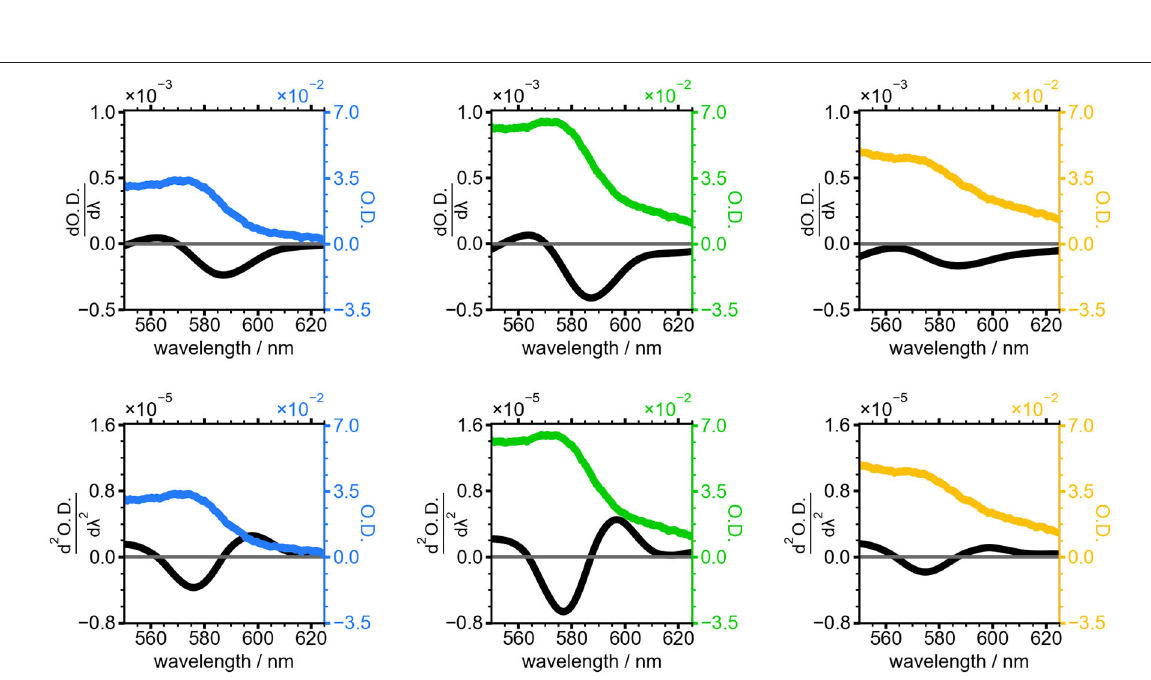
Frontiers in Chemistry |